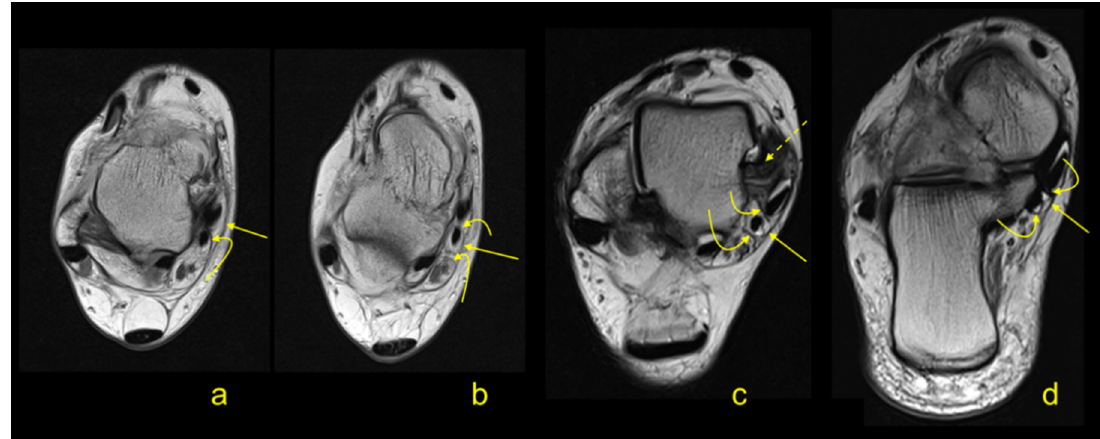
Figure 4. ( a , b )—a 23-year-old patient with clinical suspicion of anterior impingement. ( c , d )—a 39-year-old patient with clinical suspicion of rheumatoid arthritis. ( a – d )—PD weighted images. FR (straight arrow) communicates with the fibrous sheath of flexors (FFS) (curved arrow) and with the anterior tibiotalar part (ATTP) (dashed arrow).